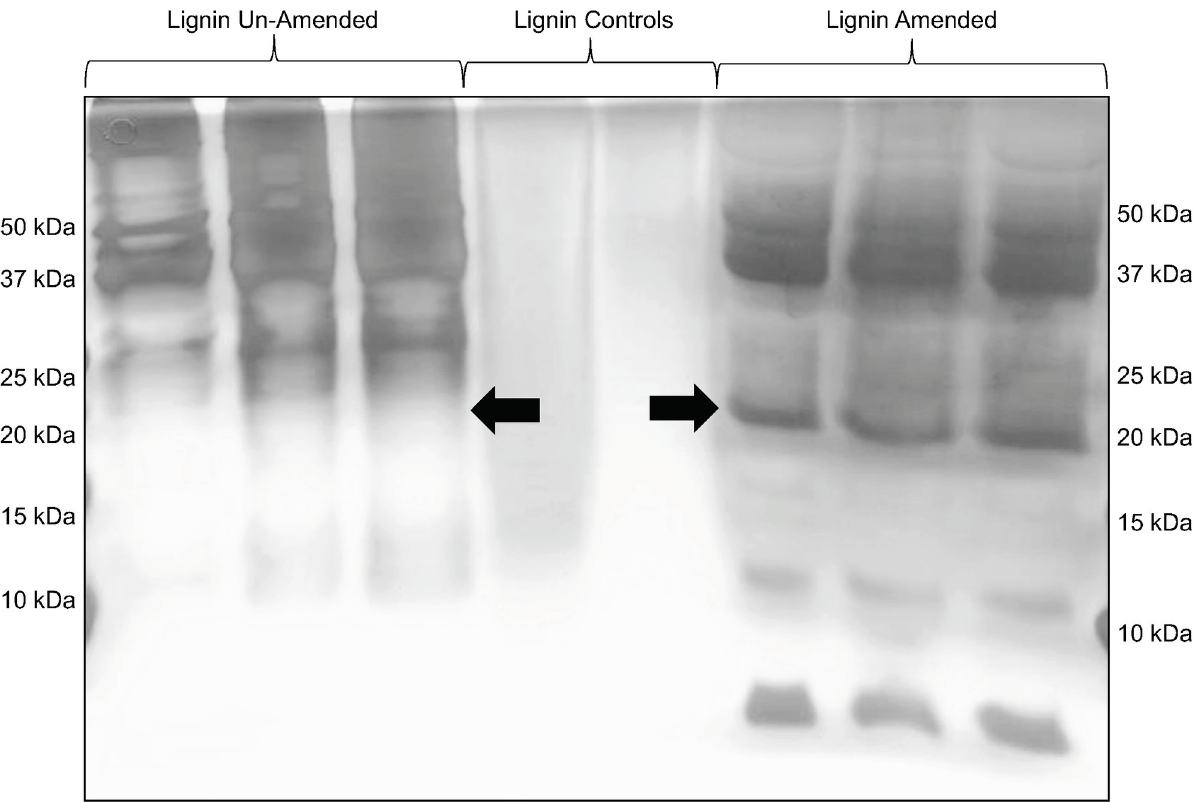
Fig 7. SDS-PAGE of secretome of T . lignolytica BRL6-1 cultured in lignin-amended and unamended conditions. Arrows showing differential banding at 20kDa.